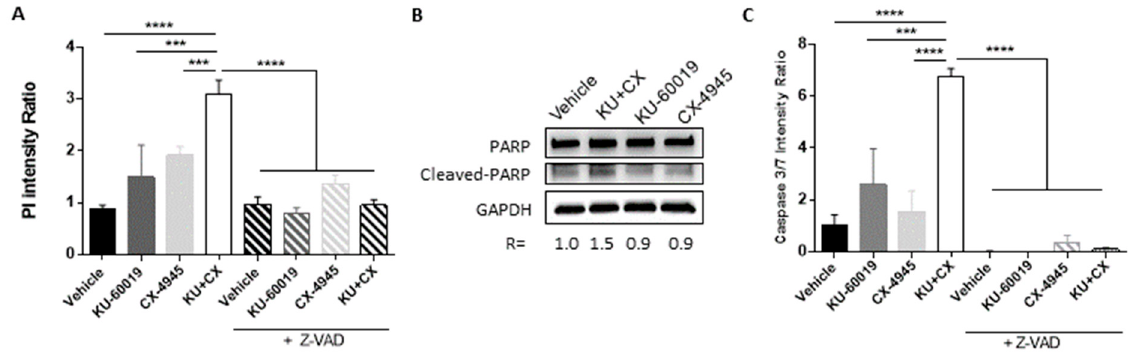
Figure 3. Combined CK2/ATM inhibition induces apoptosis in MCTS. ( A ) 786-O VHL − MCTS were incubated with PI (0.5 µ g/mL) and the following treatments: Vehicle (DMSO), KU-60019 (10 µ M) and/or CX-4945 (5 µ M) ± Z-VAD (15 µ M). Cell mortality (PI incorporation) was assessed over 48 h using IncucyteZOOM. PI incorporation under treatments is represented at 48 h ( n = 10). ( B ) Western blot analysis after a 24 h treatment showing expression level of PARP, cleaved-PARP and GAPDH as loading control. ( C ) 786-O VHL − MCTS were incubated with Caspase 3/7 Fluorescent reagent (5 µ M) with the indicated treatments as in ( A ). Apoptosis was assessed over 24 h using IncucyteZOOM. Cleaved-caspase detection is represented after 16 h of treatment ( n = 6). One-way ANOVA statistical analysis was used, *** p < 0.001, **** p < 0.0001.